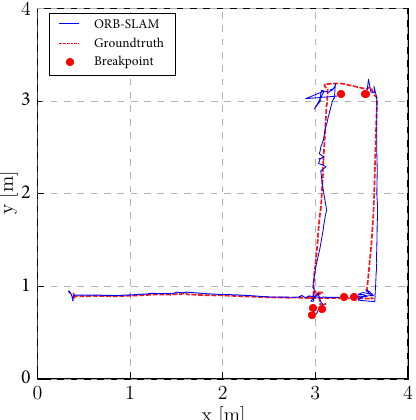
Figure 15. ORB-SLAM in Tracked 2 (Cross and Up-down Slopes) test. It lost track three times. We reset the ORB-SLAM once it lost track and get four individual trajectories. The red points indicate the beginning and end of four trajectories. Note that since we align trajectories separately, the aligned result could look good, which should not be treated as the real performance of this